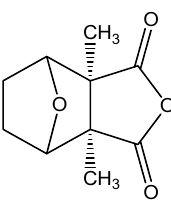
Figure 1. Structure of cantharidin.